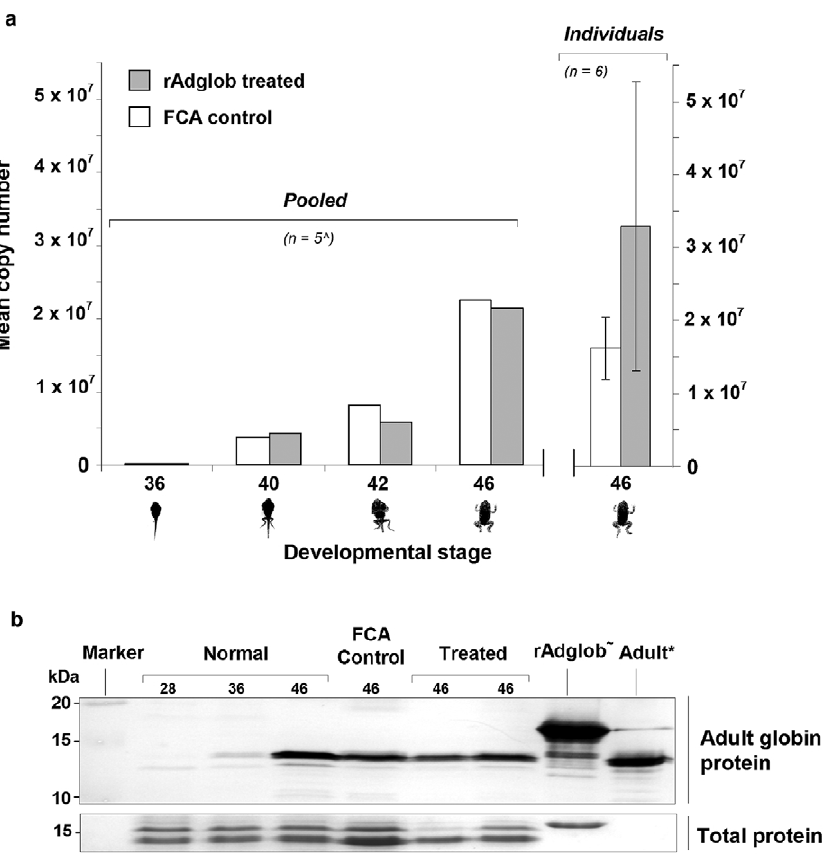
Figure 4. Adult globin mRNA and protein expression levels in treated and untreated Bufomarinus . a: The profile of adult globin mRNA expression across metamorphosis for treated rAdglob injected (grey shading) and control FCA only injected (white) animals was determined by real time-PCR analysis. Each stage point indicates the overall expression level for five pooled ( ‘ ) animals, with treated and control animals showing similar copy numbers. The last stage point represents an average of 6 individuals. Adult globin copy number was normalised to a toad actin housekeeping gene. b: Western blot analysis of whole animal extracts (upper panel) provides a general indication of the adult globin protein levels in normal developing animals (stages 28, 36 and 46), as well as FCA control and rAdglob treated animals. The lower panel shows the Coomassie brilliant blue staining for the same blot and provides an indication of total protein loading. rAdglob ( , ) is an additional 3.3 kDa larger than native adult globin due to His x6 tag and linker. Adult (*) control was generated using purified globin from the RBCs of adult B. marinus . The blot is representative of rAdglob treatments (n=10) and FCA controls (n=9).